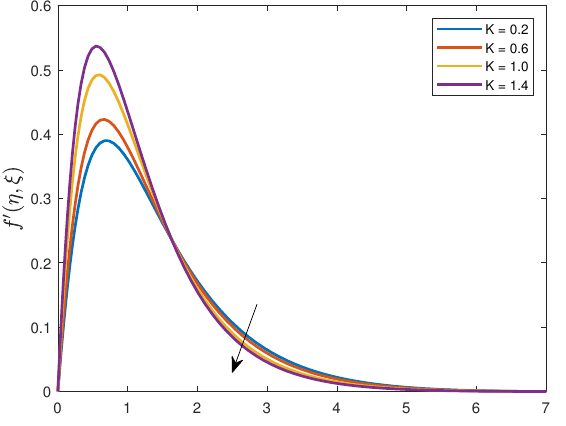
Figure 7. The influence of K on fluid velocity.